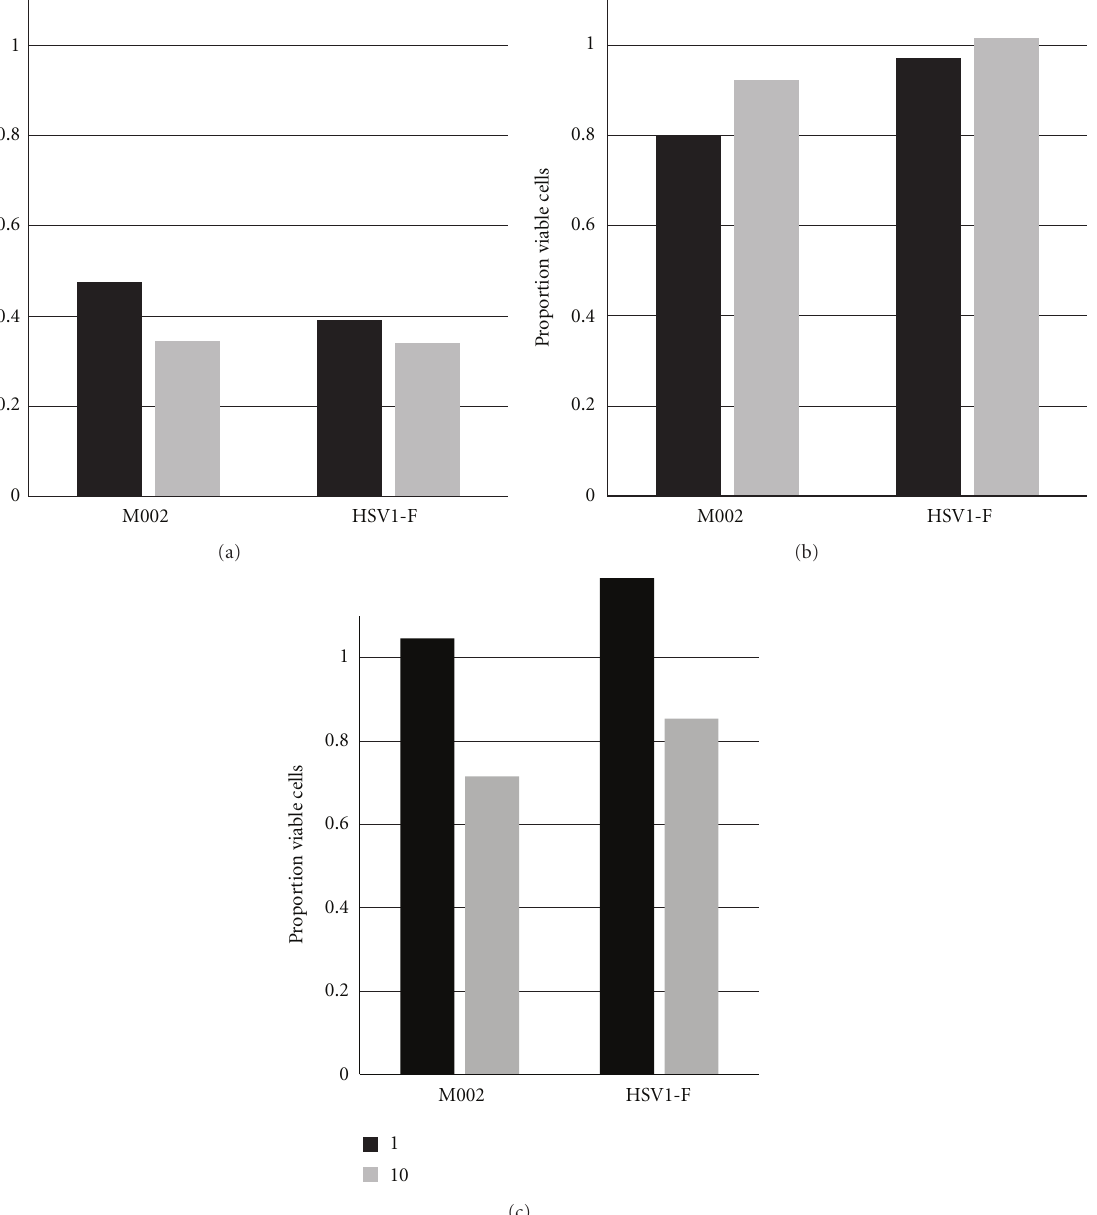
Figure 4: Cytotoxicity of M002 in human and murine tumor cells at 48h post-infection. Plates of human breast cancer cells MDA-MB-361 (a) or murine mammary carcinoma cells SCK (b), and 4T1 (c) were infected with the indicated viruses at an MOI of 1 (black bars) or 10 (gray bars) PFU/cell. At 48h post-infection, cell viability was assayed by MTT assay. Shown are the averages of quadruplicate determinations, normalized to uninfected cells and expressed as the proportion viable